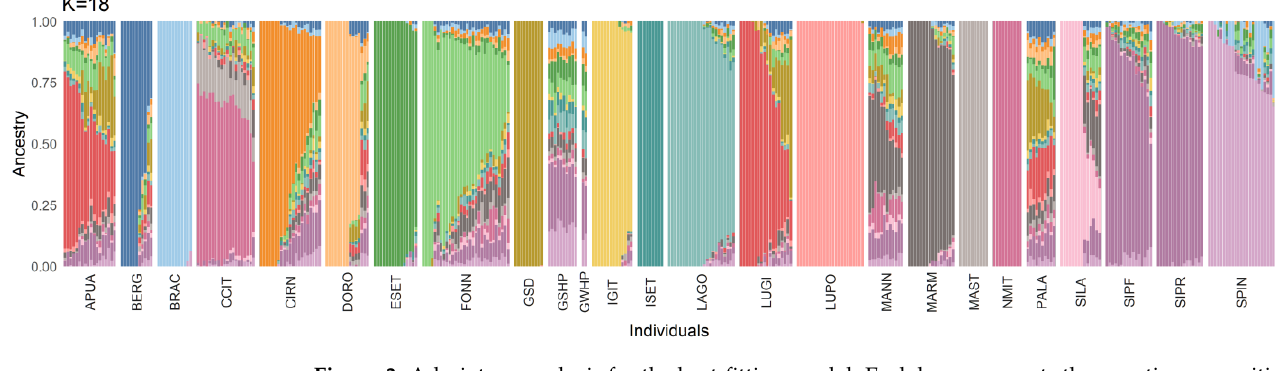
Figure 3. Admixture analysis for the best-fitting model. Each bar represents the genetic composition of a subject, according to the Q-value of the 18 clusters (K) included. Breeds included: Fonni’s dog (FONN), Pastore Apuano (APUA), Bergamasco Shepherd (BERG), Bracco Italiano (BRAC), Cane Corso Italiano (CCIT), Cirneco dell’Etna (CIRN), Pastore D’Oropa (DORO), English Setter (ESET), German Shepherd dog (GSD), German Shorthaired Pointer (GSHP), German Wirehaired Pointer (GWHP), Italian Greyhound (IGIT), Irish Setter (ISET), Lagotto Romagnolo (LAGO), Lupino del Gigante (LUGI), Lupo Italiano (LUPO), Mannara dog (MANN), Maremma and the Abruzzi Sheepdog (MARM), Mastiffs (MAST), Neapolitan Mastiff (NMIT), Pastore della Lessinia e del Lagorai (PALA), Pastore della Sila (SILA), Segugio Italiano a Pelo Forte (SIPF), Segugio Italiano a Pelo Raso (SIPR), and Spinone Italiano (SPIN).